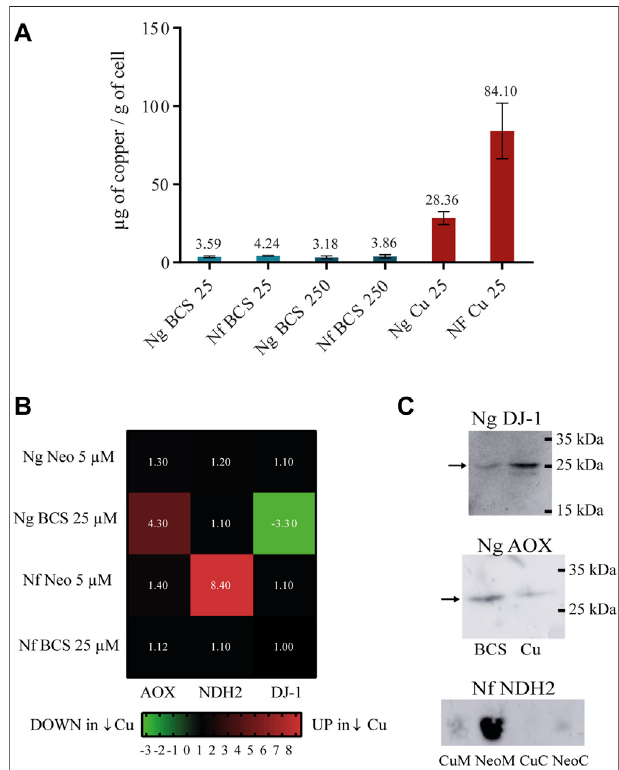
FIGURE 2 | Effect of copper availability on Naegleria gruberi and Naegleria fowleri . (A) Copper contents in N. gruberi and N. fowleri supplementedwith25 µMCu 2 SO 4 ,25 μ MBCS,or250 µMBCSfor72 h.The values represent the mean of copper content of three individual replicates. (B) The fold changes of the most relevant proteins in this article are demonstrated on the heatmap; upregulation under copper-limited conditions is indicated by red color and downregulation by green color. The heatmap demonstrates that the chelators have different effects on both amoebas. (C) western blot analysis con fi rming the proteomic results using the speci fi c antibodies antiNgDJ-1, antiNfNDH2, and antiAOX on cell lysates of N. gruberi incubated with 25 µM BCS (BCS) or 25 µM Cu 2 SO 4 (Cu) and separated by SDS – PAGE and on cytosolic (C) and mitochondrial (M) fractions of N. fowleri cells incubated with 25 µM Cu 2 SO 4 (Cu) or 5 µM neocuproine (Neo) separated by clear native